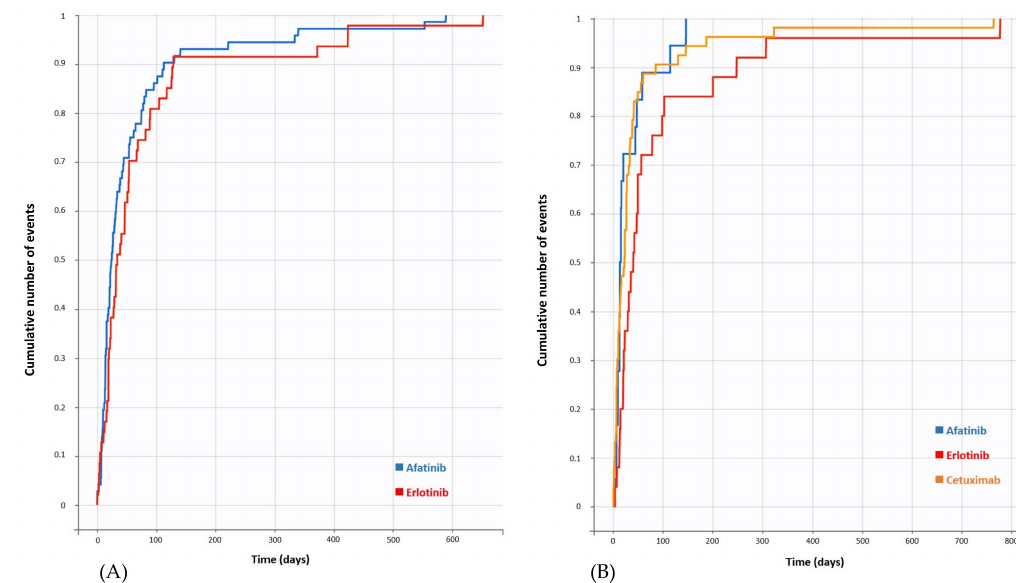
Figure 2. Cumulative distribution function of drugs studied by time to onset of acute kidney injury ( A ) or renal failure ( B ). In terms of renal failure, a significant disproportionality signal was found for afatinib (ROR = 2.41; 95% CI [1.78–3.27]), cetuximab (ROR = 1.42; 95% CI [1.14–1.78]) and erlotinib (ROR = 2.23; 95% CI [1.80–2.77]) (Table S1, Figure 1). The median TTO was 15 days (Q1 = 11; Q3 = 39) for afatinib with available data for 18 cases, 23 days (Q1 = 8; Q3 = 35) for cetuximab with available data for 53 cases and 41 days (Q1 = 21; Q3 = 79) for erlotinib with available data for 25 cases (Figure 2).